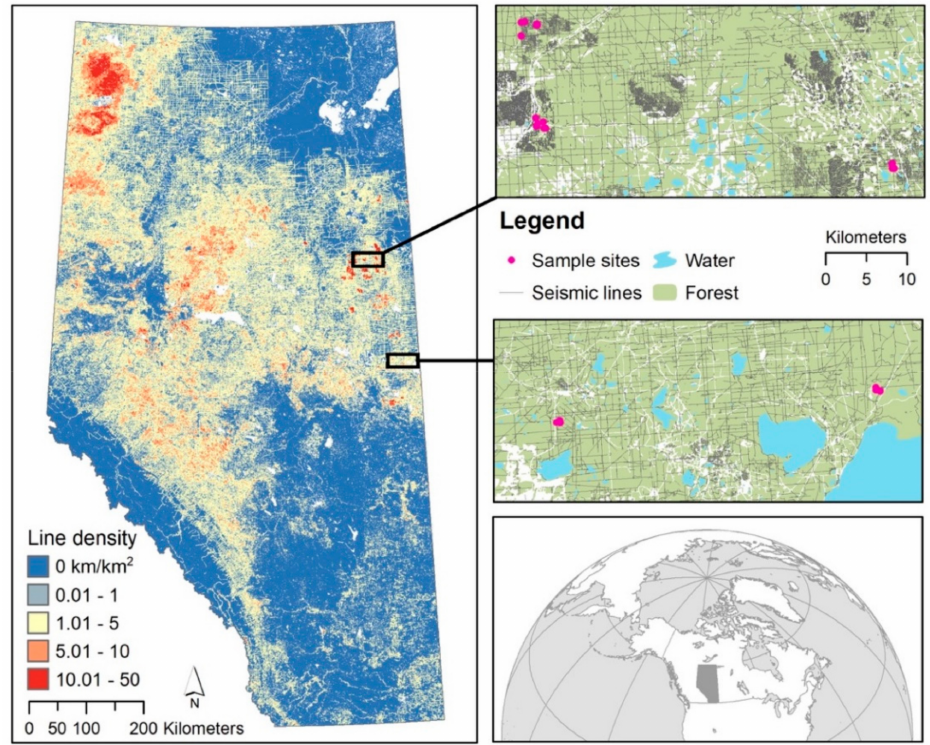
Figure 1. Map of the study area in northern Alberta, Canada. Seismic line density (per km 2 ) in the left map, location of Alberta in bottom right, and locations of sample sites in two regions of northeast Alberta in the upper right (Fort McMurray area at top, Cold Lake area in